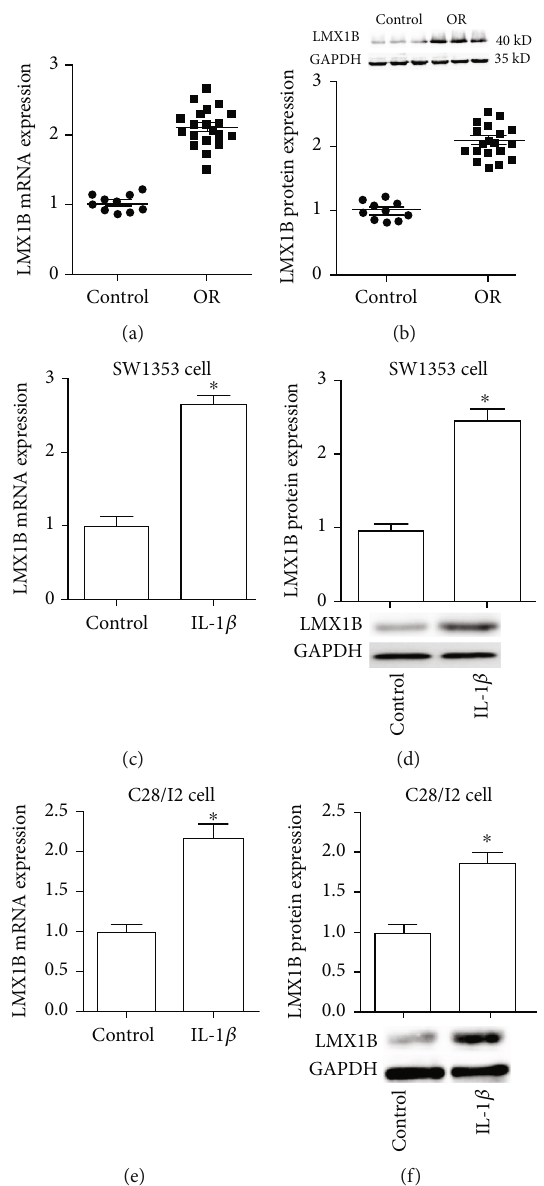
Figure 1: LMX1B was upregulated in OA cartilage tissue and IL-1 β -induced chondrocytes. (a, c, and e) qRT-PCR analysis for LMX1B mRNA expression in cartilage tissue (a), SW1353 cells (c), and C28/I2 cells (e). (b, d, and f) Western blot analysis for LMX1B protein expression in cartilage tissue (b), SW1353 cells (d), and C28/I2 cells (f). SW1353 and C28/I2 cells were treated with 10 ng/ml IL-1 β for 24h. ∗ P < 0 : 05 . 20 OA patients and 10 normal subjects were used in this study; moreover, all experiments were repeated three times in SW1353 and C28/I2